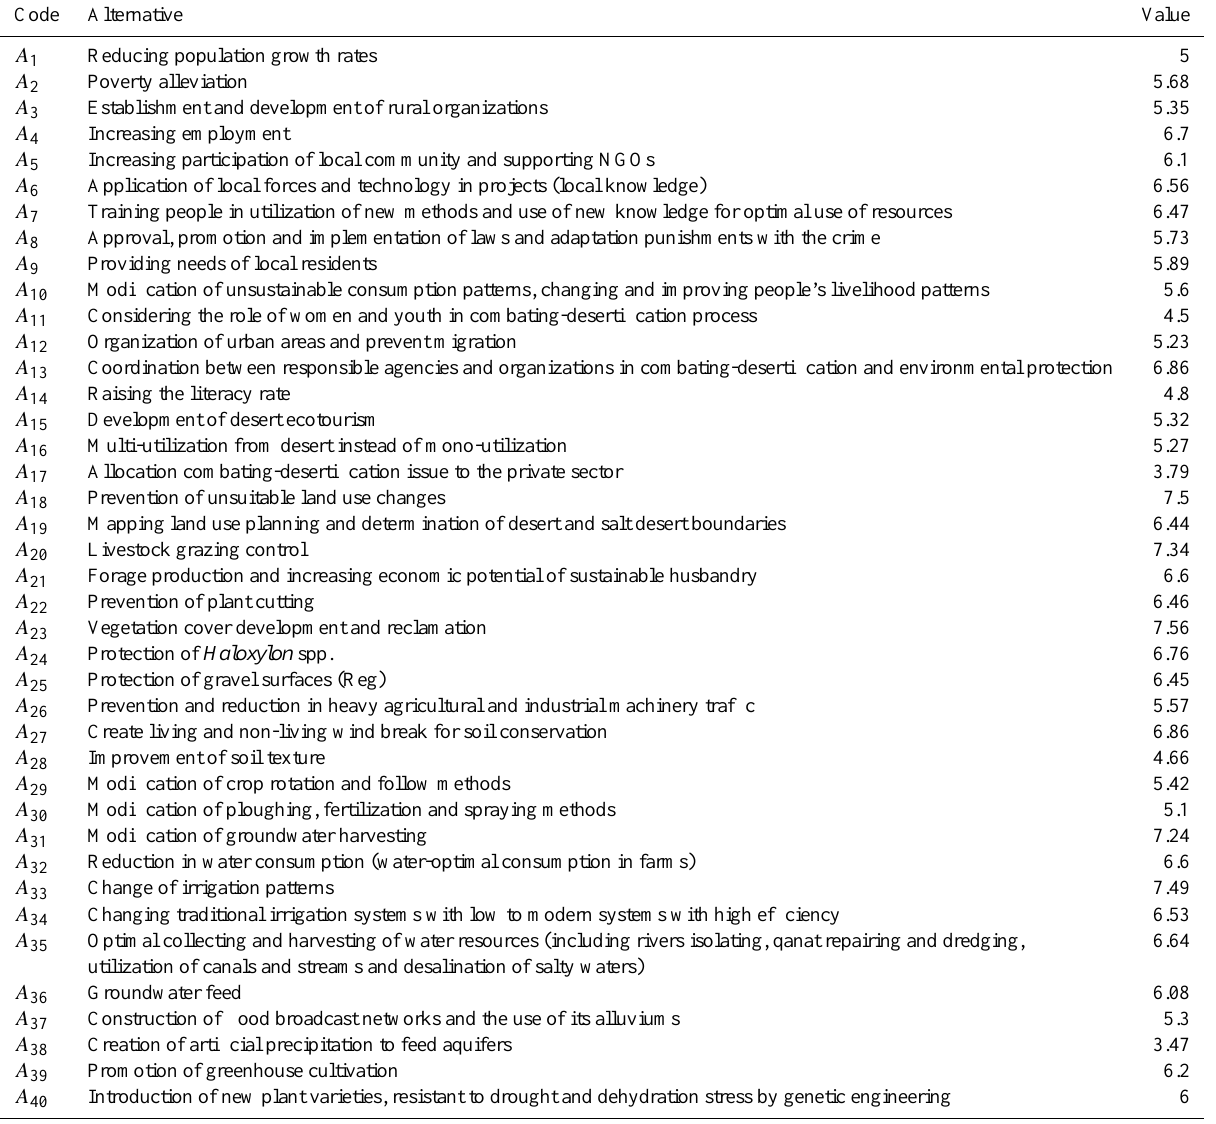
Table 9. The recommended alternatives to combat desertification and their priority according to the groups. Code